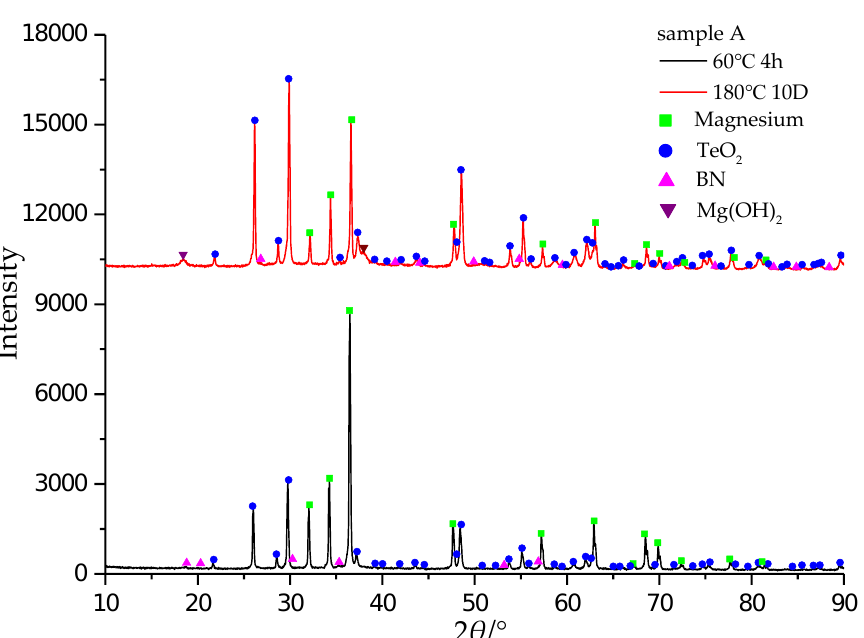
◦ C for 4 h and 180 ◦ C for 10